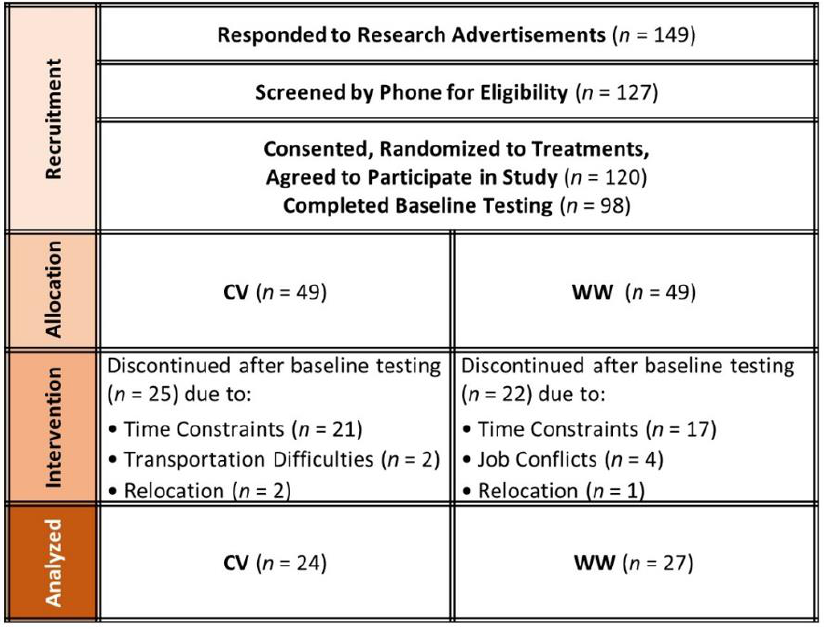
Figure 2. CONSORT diagram. CV represents the Curves fitness and weight management program. WW represents the Weight Watchers ® Momentum™ intervention group.